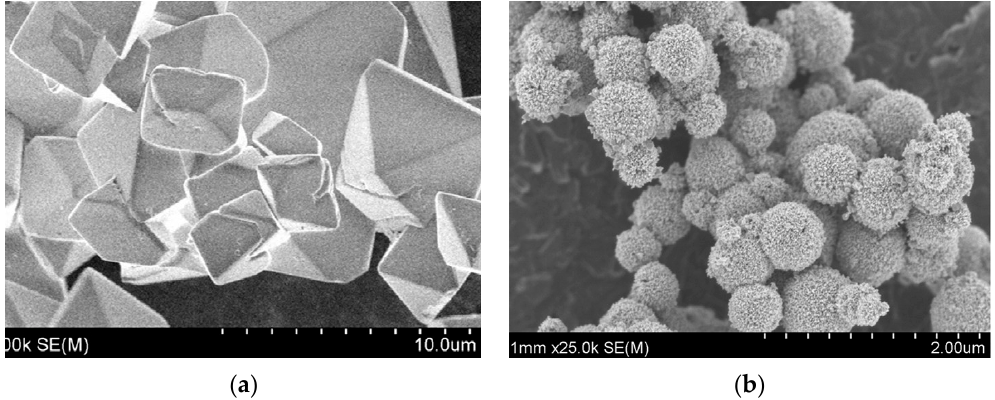
Figure 12. SEM image of bicone ZnO ( a ) and spherical ZnO ( b ). Reproduced with permission from [240]. Copyright Elsevier, 2008.